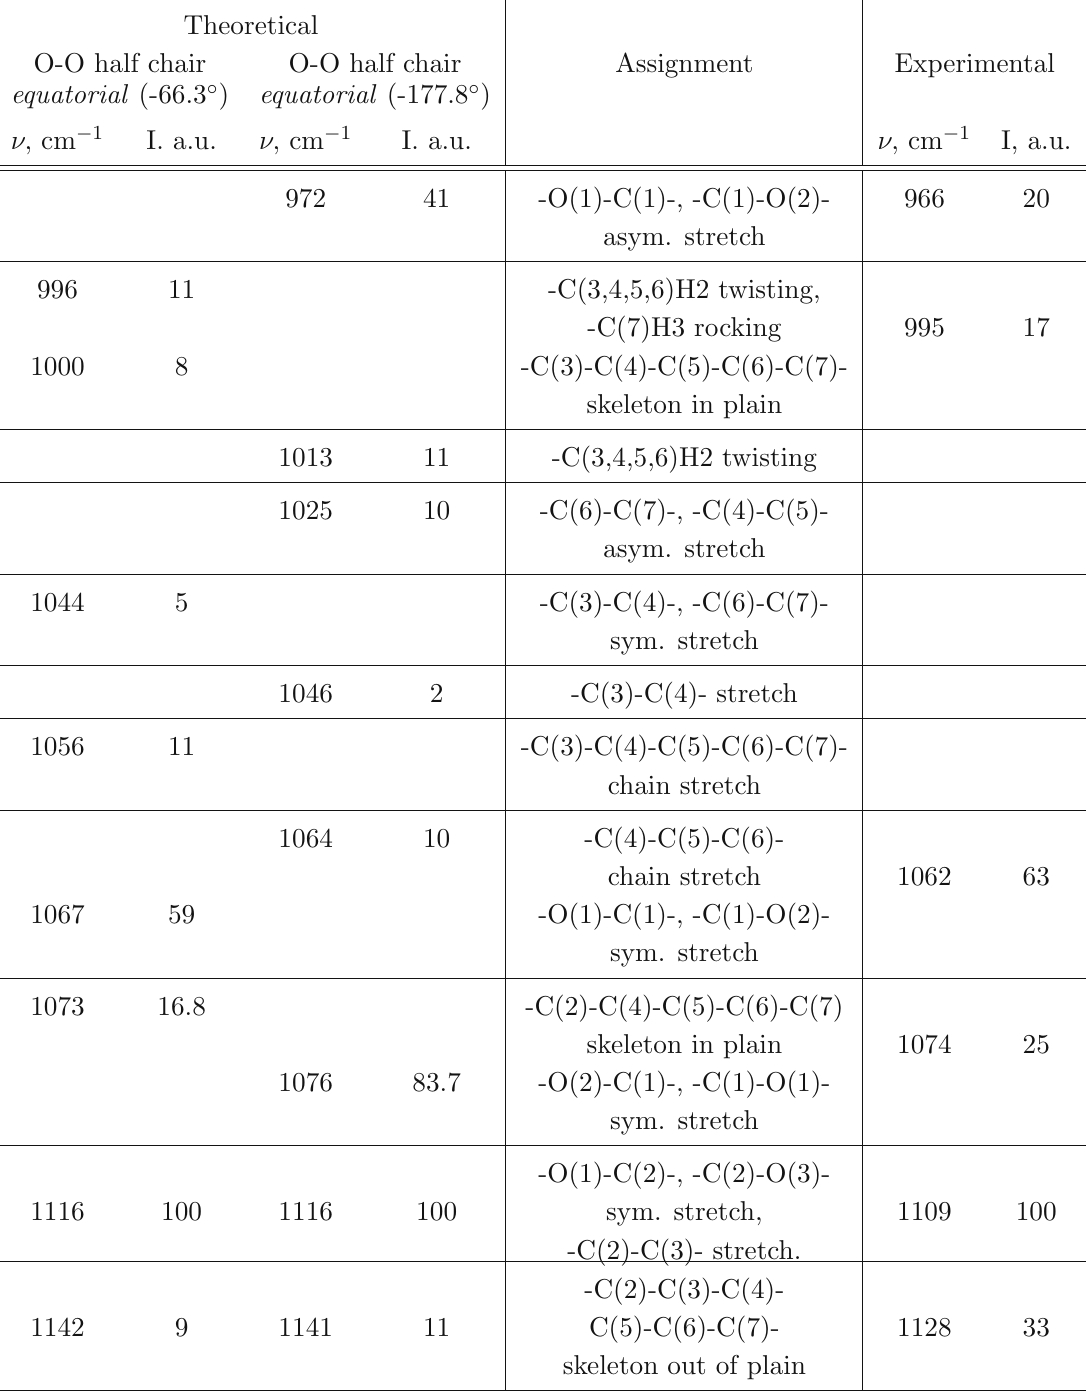
Table 4 Experimental and theoretical infrared absorption spectral bands of 1-heptene